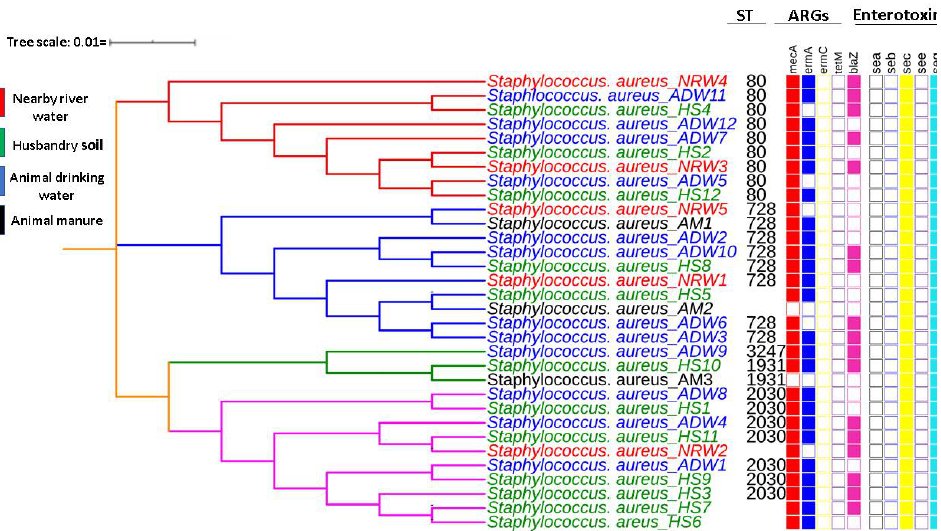
Figure 3. MLST-based dendrogram based on the concatenated of the seven housekeeping genes of MRSA isolates from HS, AM, ADW, and NRW highlighting selected ARGs and enterotoxins. MRSA isolates from HS, AM, ADW, and NRW highlighting selected ARGs and